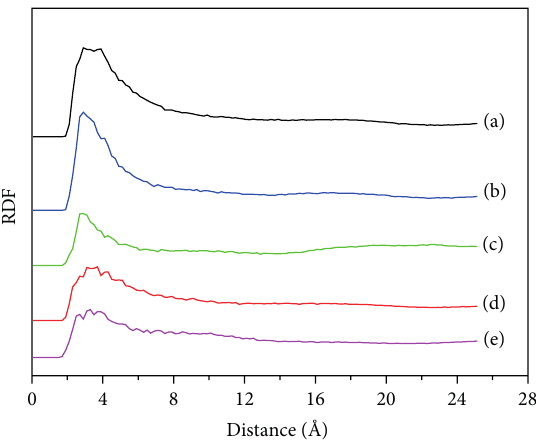
Figure 7: Radial distribution functions of the center of mass for hydrogen molecules at different temperatures: (a) 77 K, (b) 160K, (c) 195K, (d) 230K, and (e) 293 K at 10kPa.